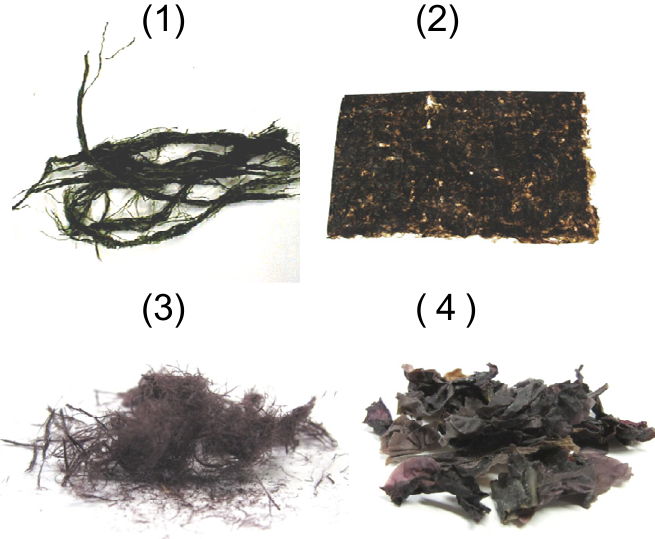
Figure 2. Various types of dried green and purple lavers are Vitamin B ( 1 ) a Japanese green laver, (Suji-aonori, Entromopha prolifera ); ( 2 ) ordinary purple lavers ( Porphyra sp.; nori, which has been formed into a sheet and dried); ( 3 ) Taiwan purple laver (Hong-mao-tai, Bangia atropurpurea ); and ( 4 ) New Zealand purple laver (Karengo, a mixture of Porphyra cinnamomea and Porphyra virididentata